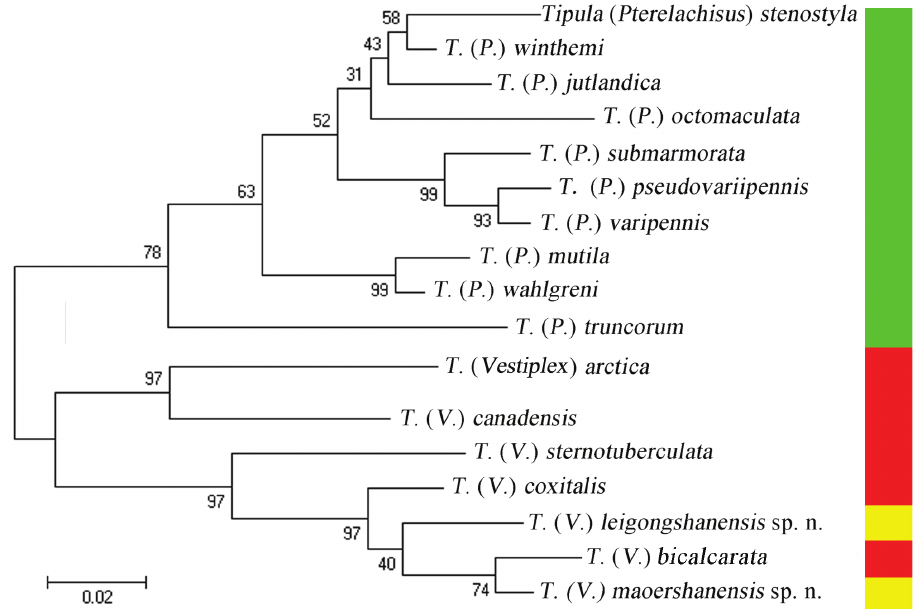
Figure 39. Maximum likelihood tree based on COI sequences of new species and some known species of Tipula ( Vestiplex ) and Tipula ( Pterelachisus ). Green region represents species of Tipula ( Pterelachisus ); red region represents species of Tipula ( Vestiplex ); yellow region represents new